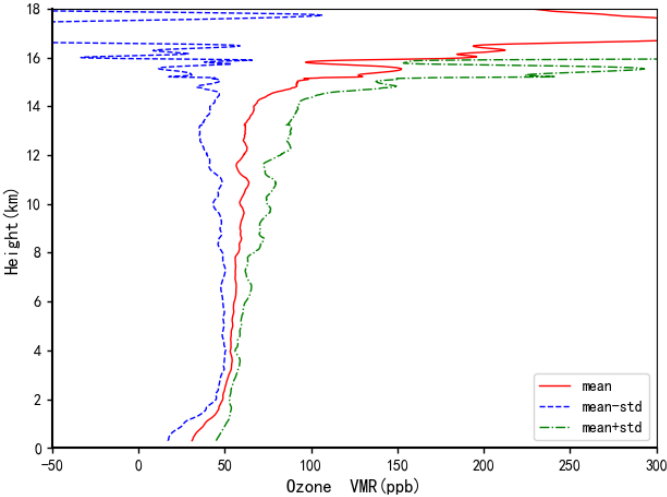
Figure 3. The averaged profiles of ozone VMR at the Shaowu observation station in the winter of 2022. The red line represents the mean state of ozone VMR. The blue or green dashed line represents the profile of mean state minus or plus standard deviation of ozone VMR, respectively.